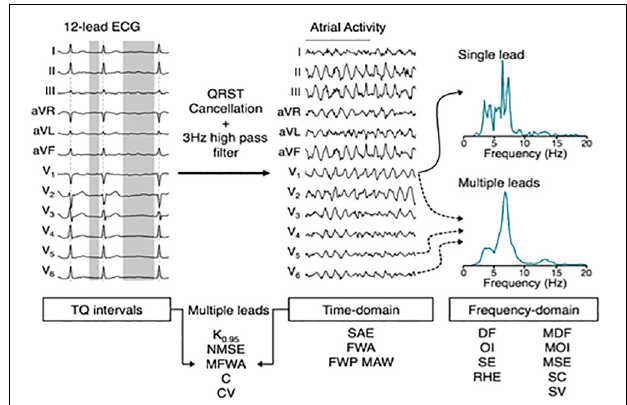
FIGURE 6 | Overview of electrocardiogram (ECG) signal processing and complexity parameter computation. In the time-domain, multi-dimensional parameters derived from multiple leads can be computed on both the extracted atrial activity, as well as on the TQ-segments of the original ECG. In the frequency domain, complexity can be quantified based on spectra computed from a single lead or multiple leads. DF, dominant frequency; OI, organization index; SE, spectral entropy; RHE, relative harmonic energy; MDF/MOI/MSE, multi-dimensional DF/OI/SE; SC, spectral concentration; SV, spectral variability; SAE, sample entropy; FWA, fibrillation wave amplitude; FWP MAW, fibrillation wave power of the main atrial wave; K0.95, C, spatial complexity parameters; NMSE, CV, variability of spatial complexity; MFWA, multi-dimensional FWA. With permission from Zeemering et al.